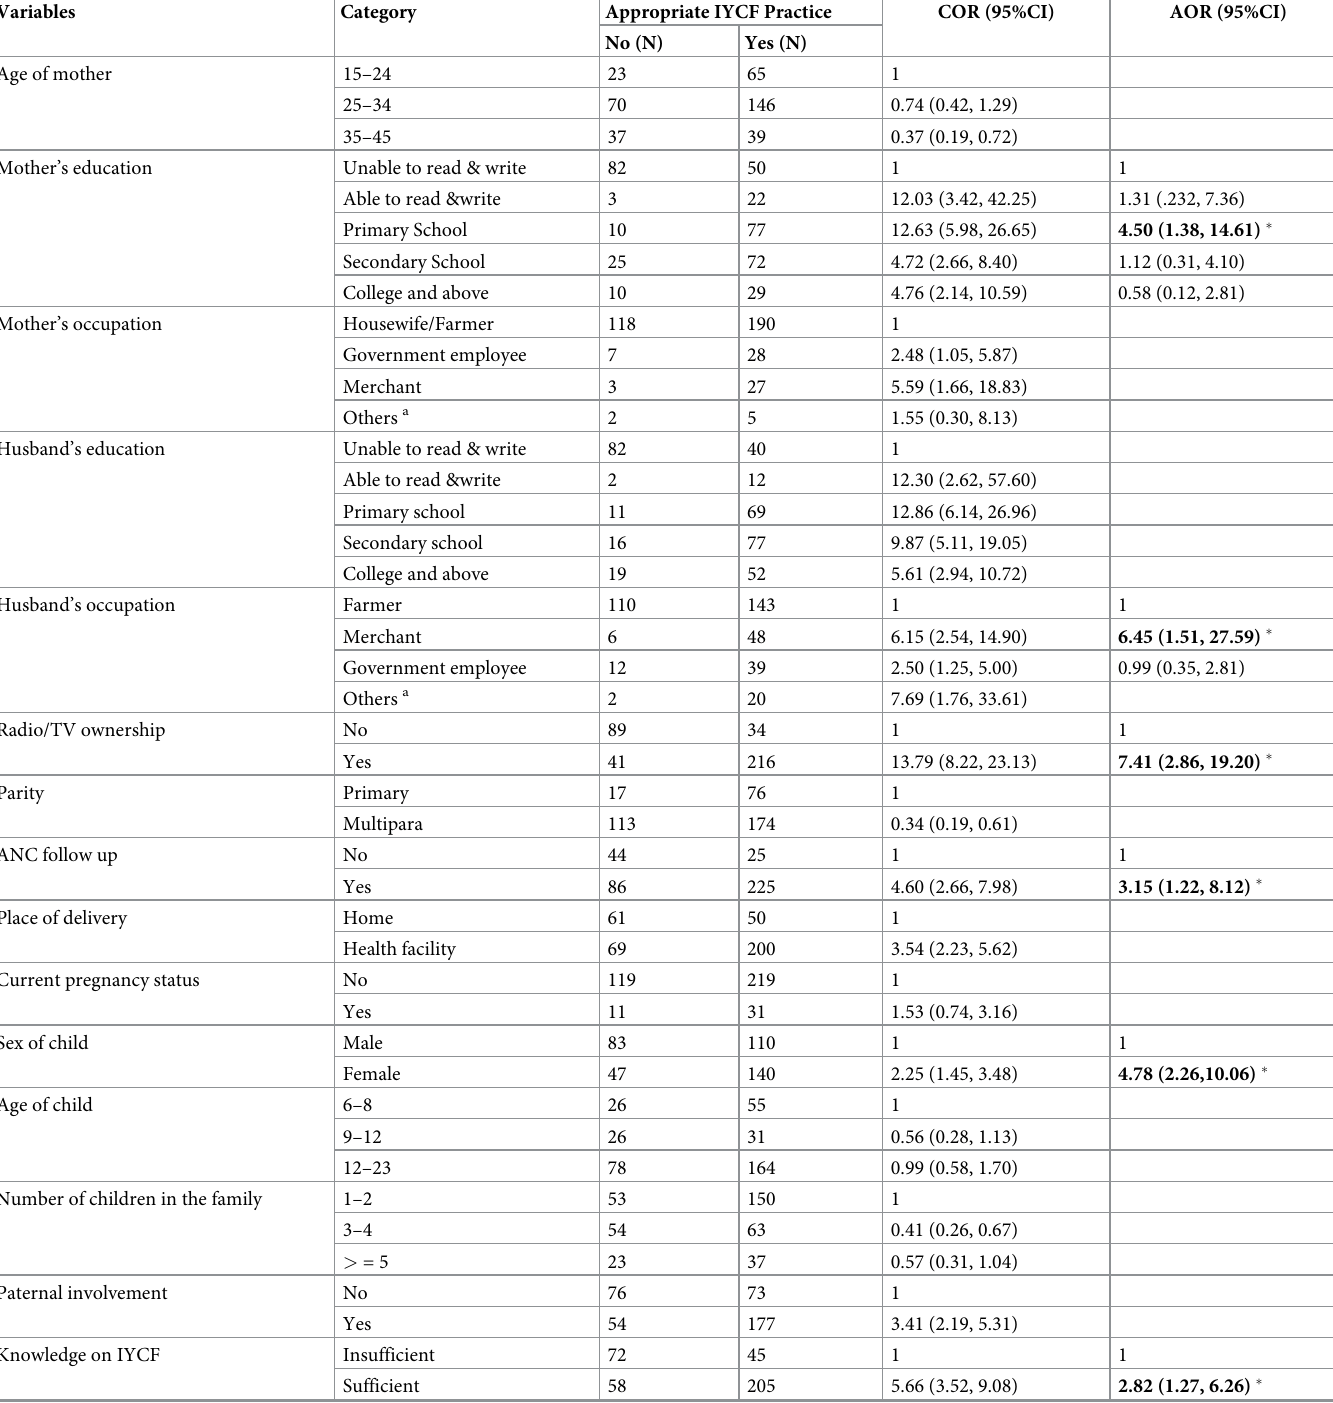
Table 4. Binary and multiple variables logistic regression analysis of factors associated with IYCF practices among mothers with children age between 6 to 23 months at Debrelibanos district, north Showa, Oromia, Ethiopia.